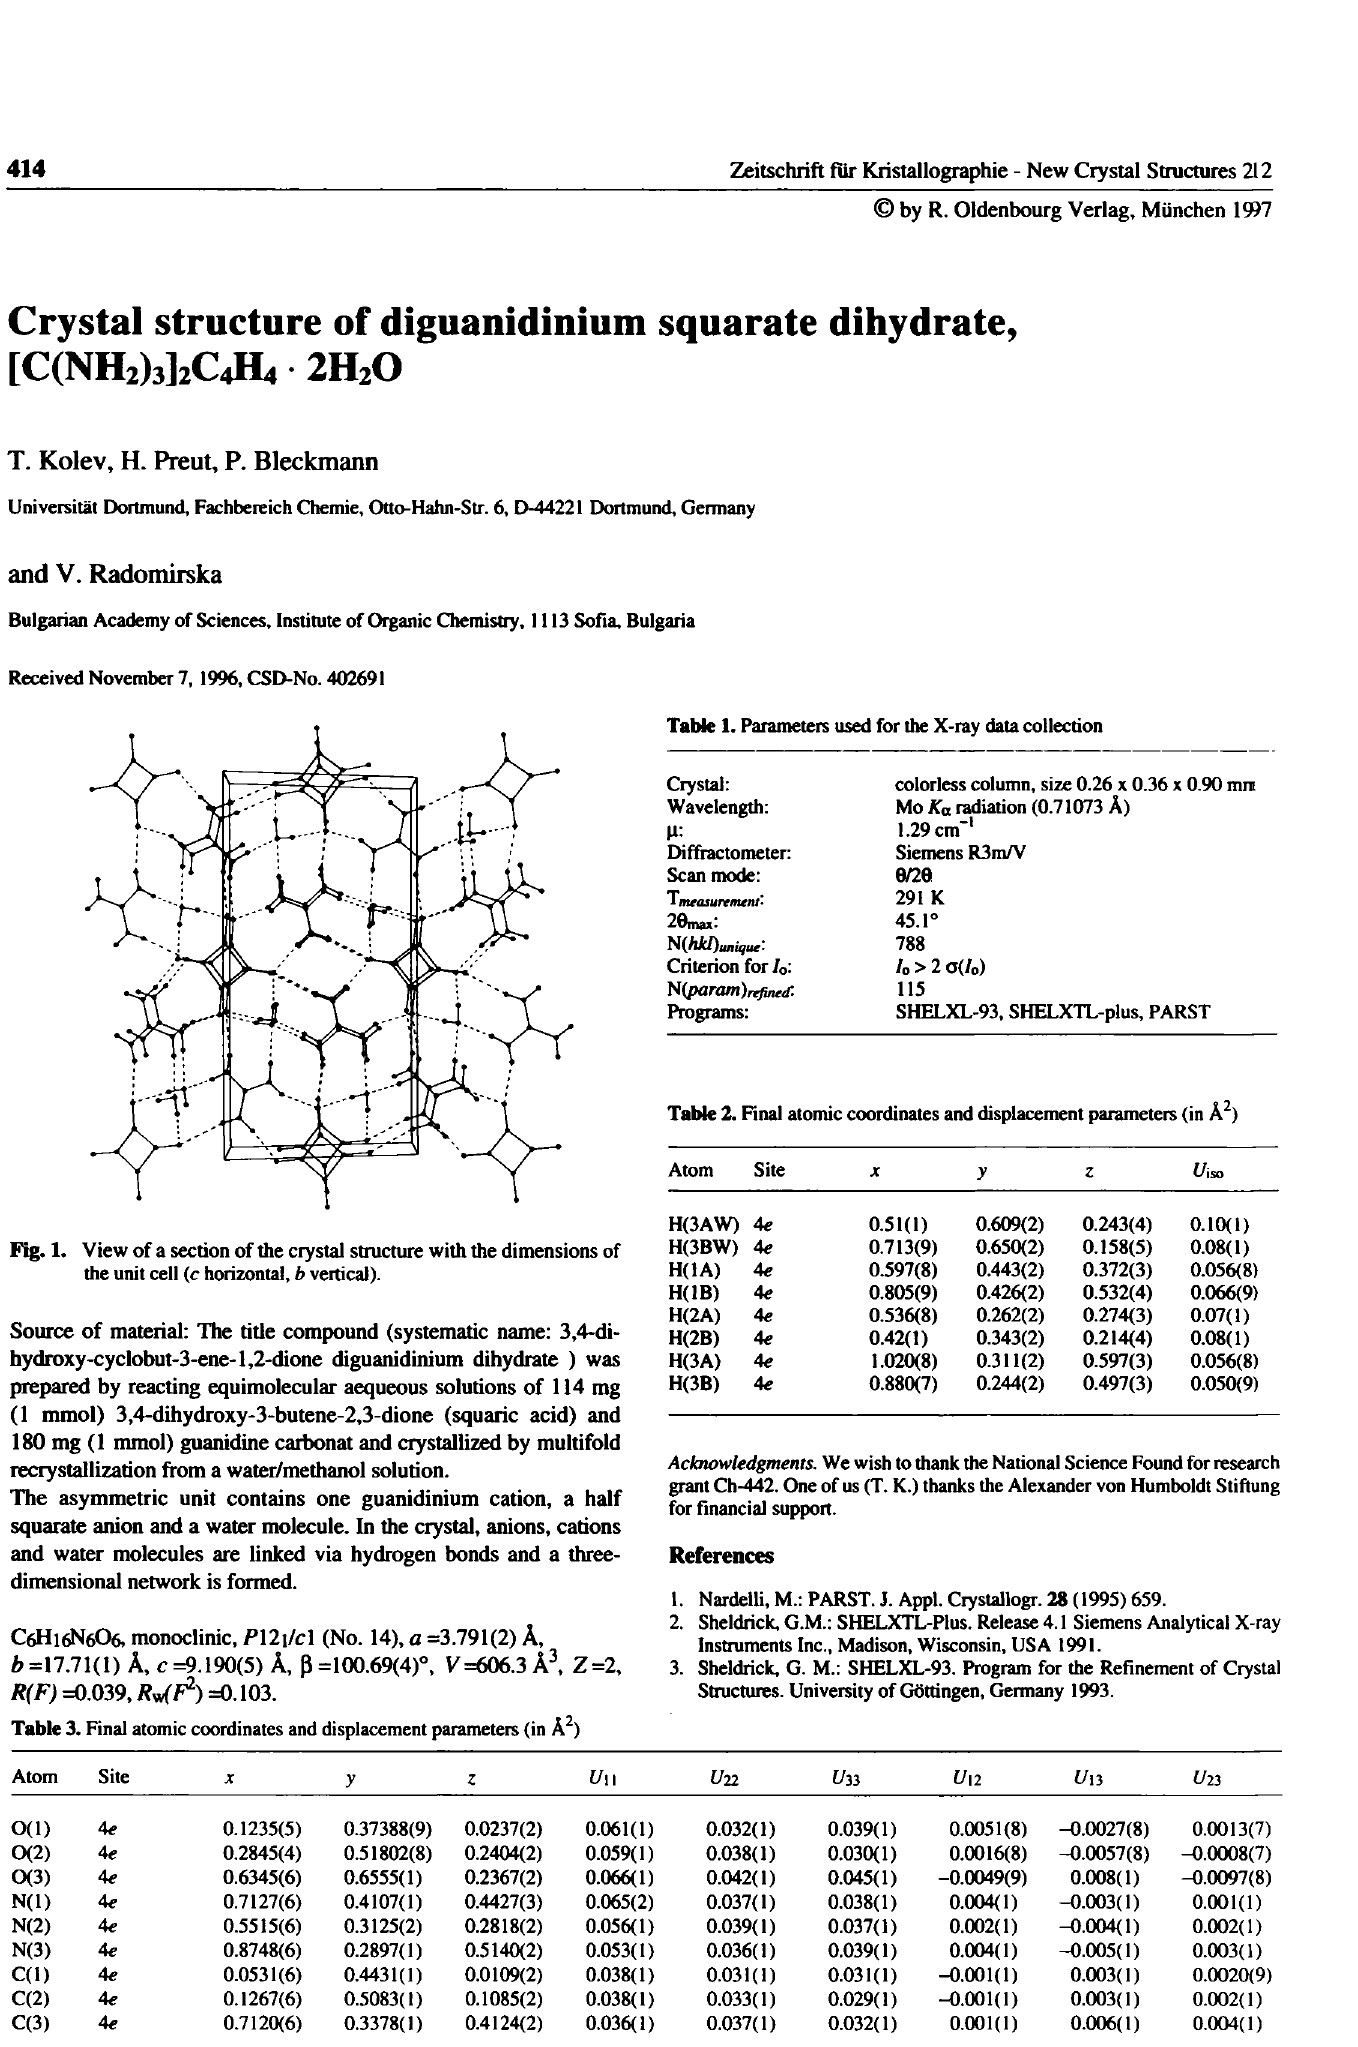
Table 1. Parameters used for the X-ray data collection Crystal: